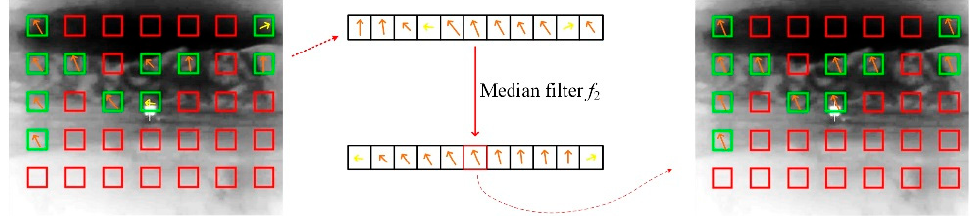
Figure 7. Median filter f 2 to select the global motion vector.